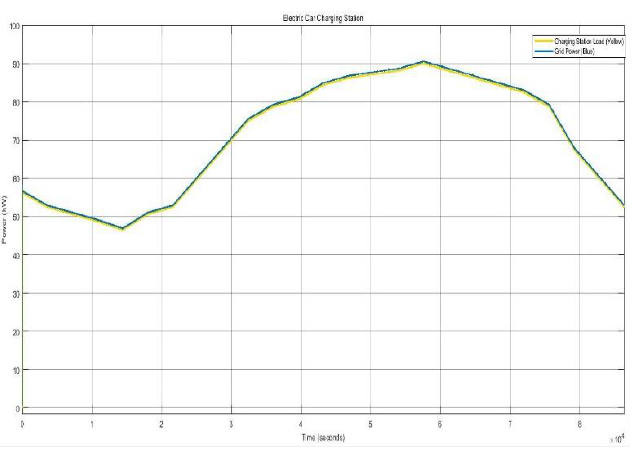
Fig. 6. Grid only case